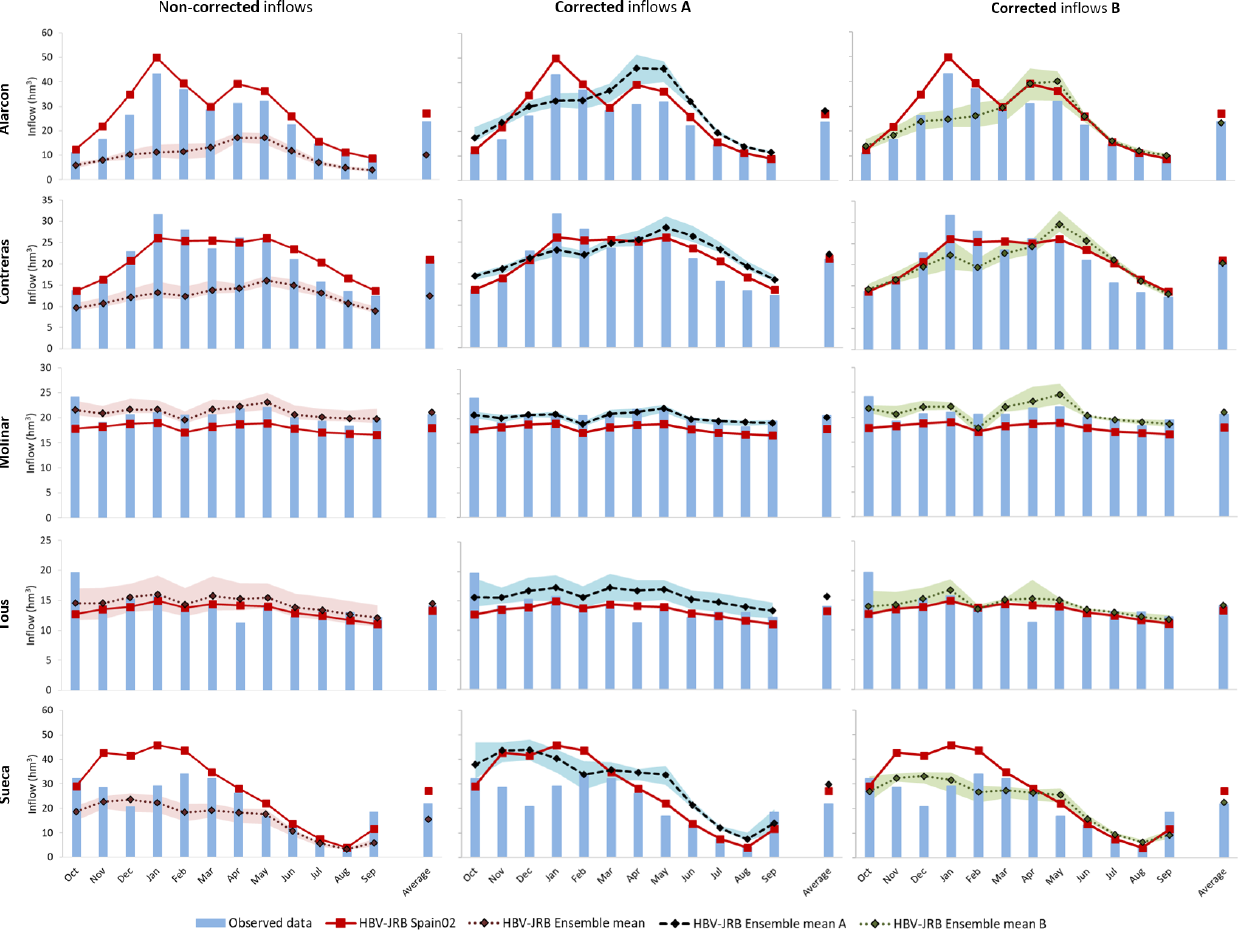
Figure 5. Average monthly and yearly inflows from the application of the HBV model using historical (HBV-JRB Spain02) and raw ensemble data (HBV-JRB ensemble mean and shaded area) compared to the observed (Observed data) and corrected inflows (HBV-JRB ensemble mean A, HBV-JRB ensemble mean B and shaded areas) in the reference period